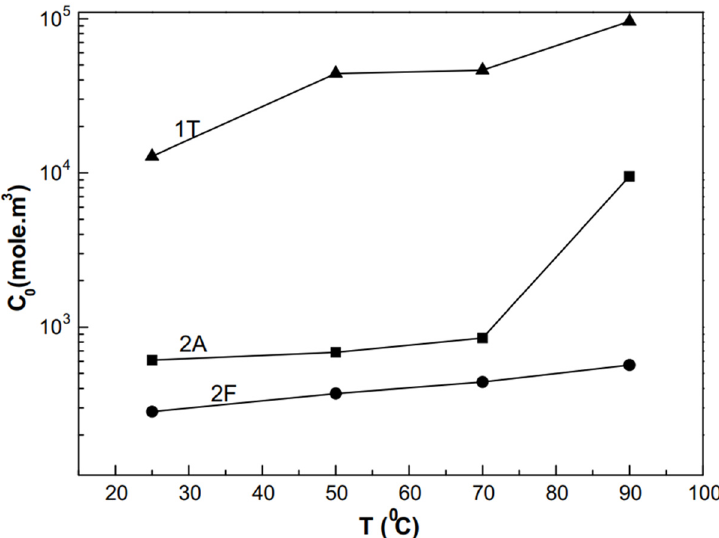
Figure 9. Effect of increasing temperature on hydrogen atom concentration (C 0 ) on the surface of the different steel microstructures: 2F (martensitic microstructure); 2A (ferritic microstructure); 1T (ferritic/bainitic microstructure) [61]. Reprinted with permission from [61], 2008, Elsevier.